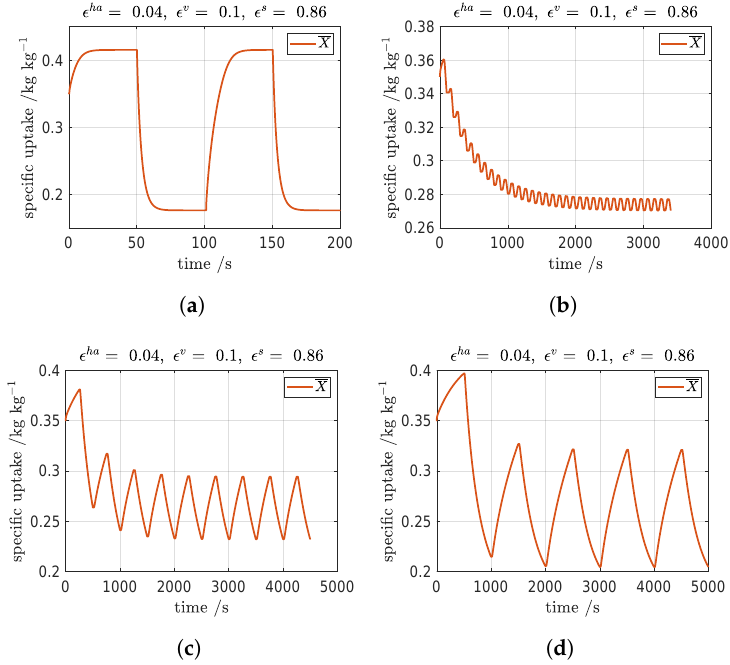
Figure 7. Mean specific uptakes from initialization to cyclic steady state for simulations with different layer thickness and cycle time. The composition of the CDC-plates is the same for these simulations with (cid:101) ha = 0.04, (cid:101) v = 0.1 and (cid:101) s = 0.86. ( a ) Cycle time of 100 s and layer thickness of 1 mm. ( b ) Cycle time of 100 s and layer thickness of 9 mm. ( c ) Cycle time of 500 s and layer thickness of 9 mm. ( d ) Cycle time of 1000 s and layer thickness of 9